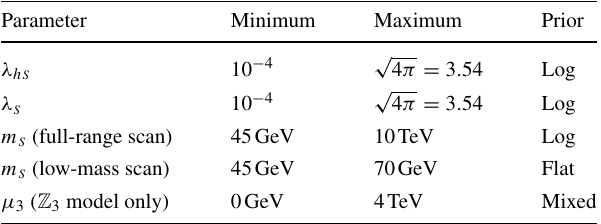
Table 1 Model parameters that we vary in our fits, as well as the ranges over which we vary them, and the types of priors that we apply to the sampling. The mixed prior for the parameter μ 3 consists of two separate scans. One scan employs a flat prior between 0 and 1GeV and a logarithmic prior from 1 to 4TeV, whereas the other scan employs a flat prior for the full